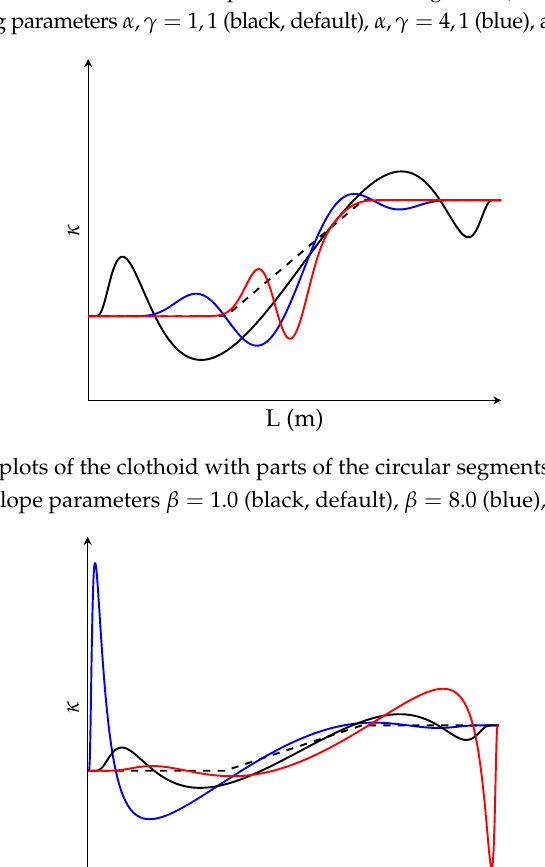
Figure 16. Curvature plots of the clothoid with parts of the circular segments (dashed) and blending splines in [ p 3 , q 3 ] for balance parameters λ = 0.5 (black, default), λ = 0.2 (blue), and λ = 0.8 (red).